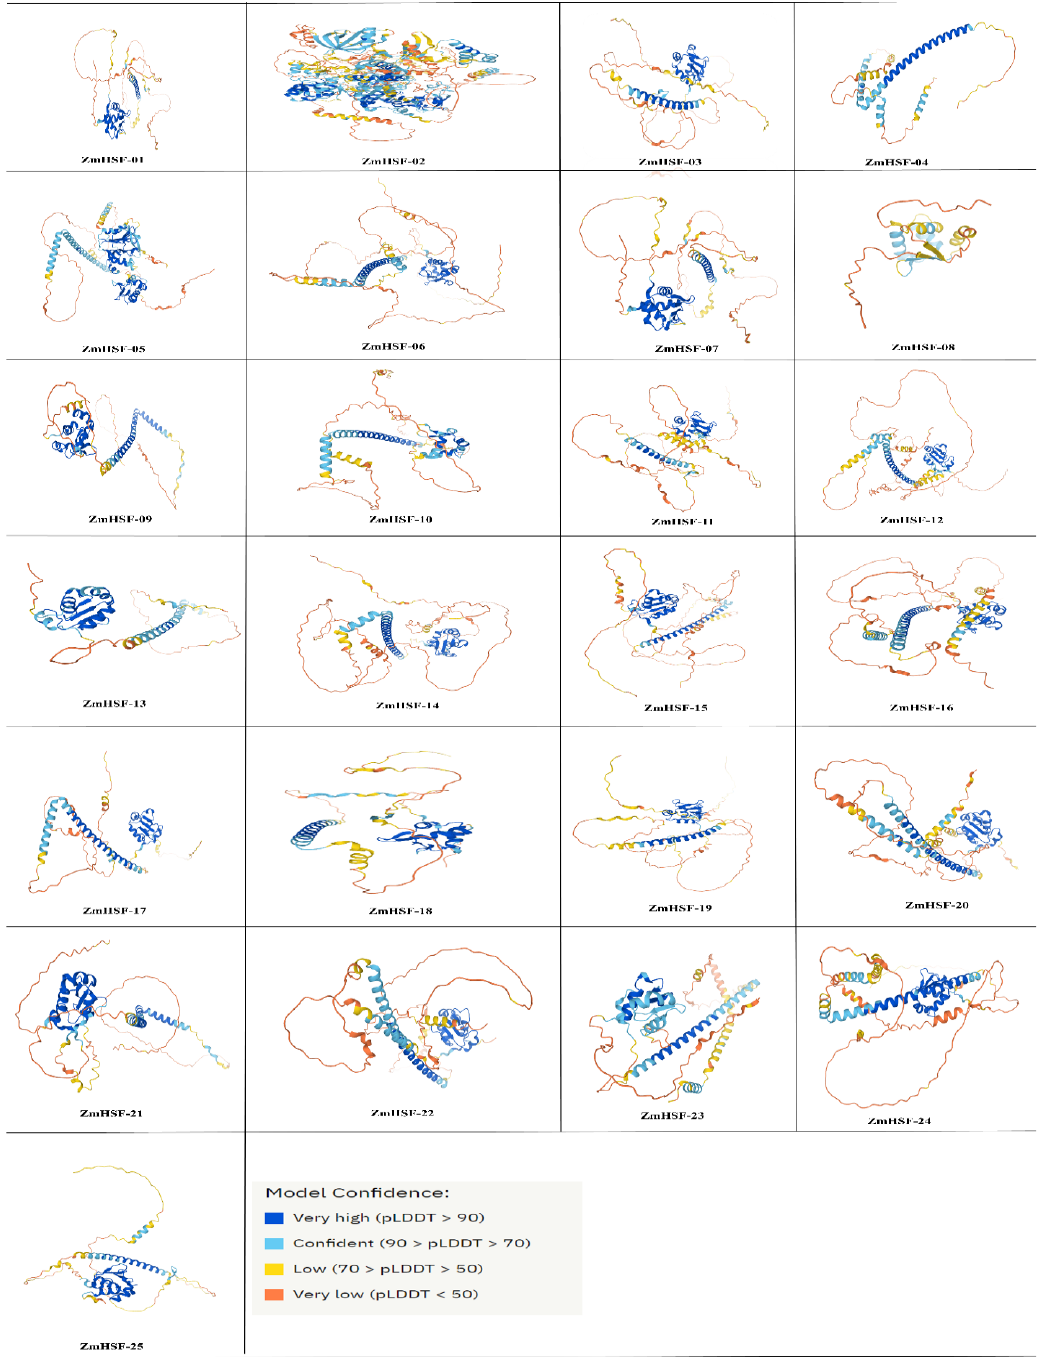
Figure 8. Protein structure of maize HSFs. The prediction confidence level is presented at the bottom. For detailed information about proteins, see Table 5.